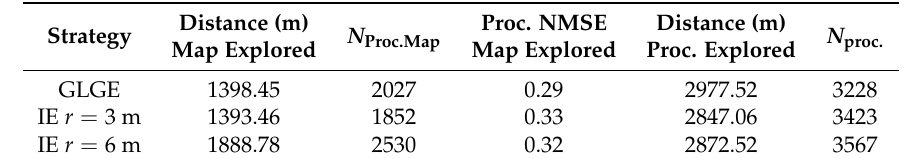
Table 7. Scenario S3: (i) mapping: Total travelled distance needed to explore the map with accompanied number of obtained process measurements N proc.,map and process NMSE; (ii) process exploration: Total exploration distance to explore the process and number of collected measurements ( N proc. ) required to achieve NMSE of 0.084 with respect to the ground truth.